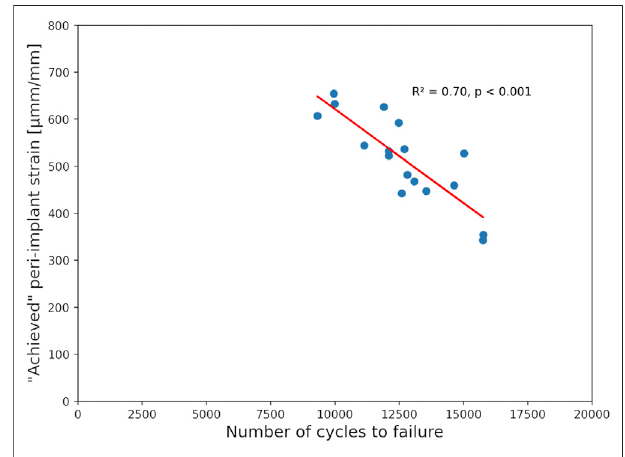
FIGURE 8 | Correlation of the experimental number of cycles until 0.5 mm cut-out failure and the peri-implant strain of the achieved FE models showing good prediction accuracy with high signi fi